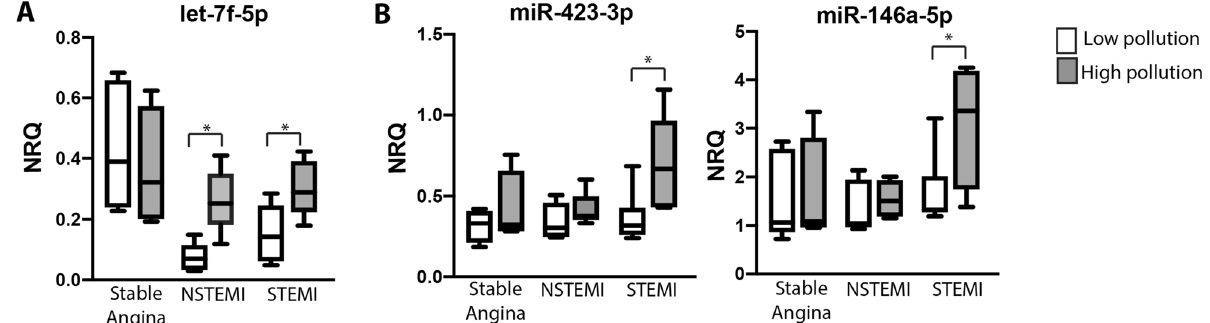
Figure 6. Circulating levels of miR-let-7f-5p, miR-423-3p and miR-146a-5p are increased in acute myocardial patients exposed to high levels of PM 2.5 . Box and whiskers Min to Max plots showing the expression of ( A ) miR- let-7f-5p and ( B ) miR-423-3p and miR-146a-5p in plasma samples from stable angina patients (n = 8), NSTEMI patients (n = 9) and STEMI patients (n = 14) exposed to low levels (empty boxes) or high levels (grey boxes) of PM 2.5 . Differences were analyzed using Mann–Whitney U test, *p <